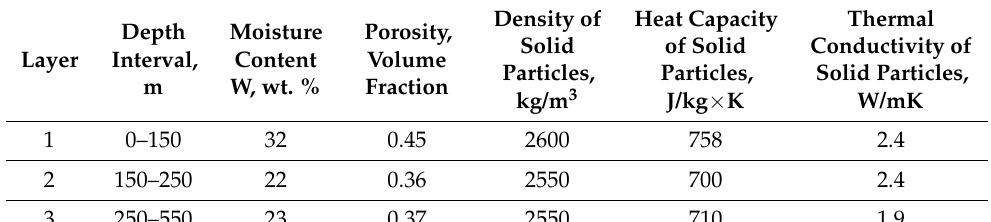
Table 1. Average physical properties of model layers.